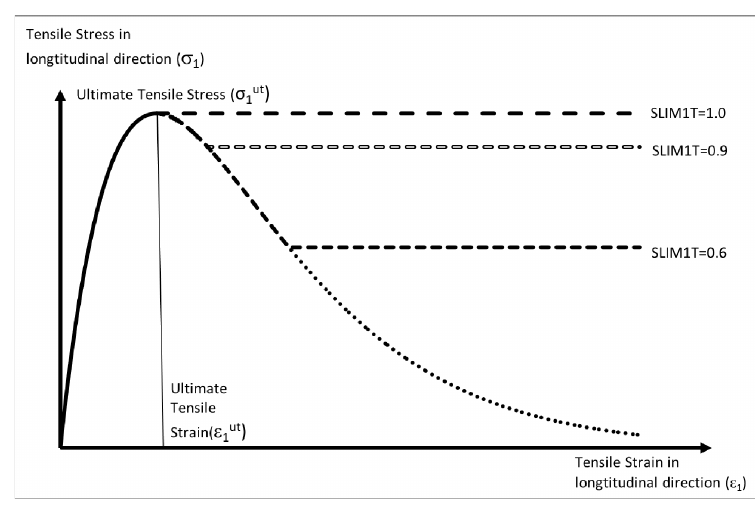
Figure 5. Effect of Slim factor (shown for longitudinal direction).